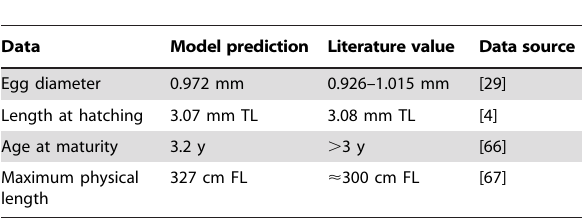
Table 7. Comparison of model results to univariate